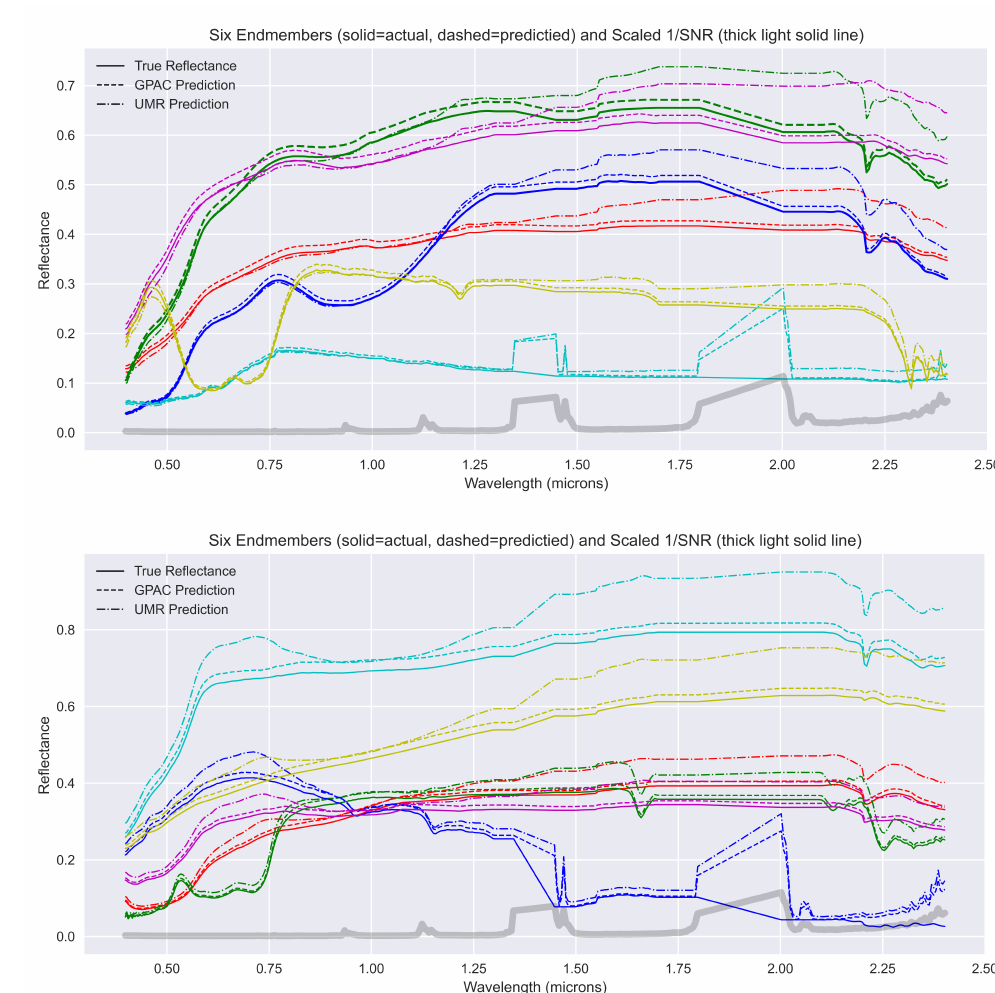
Figure 11. For two different observation endmeber sets and atmospheres, the true and predicted (using GPAC and UMR) reflectance spectra for six endmembers are shown. Also shown is 1/SNR for each band, with the SNR is the radiance value for the given band divided by the maximum radiance.